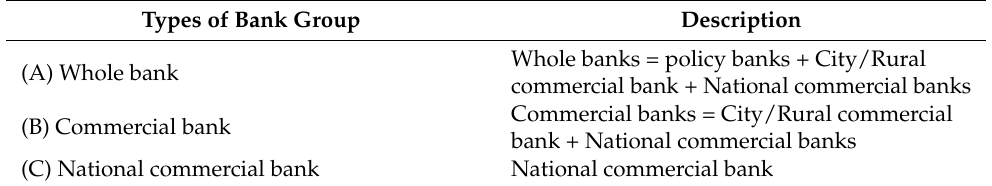
Table 8. Types of bank group.